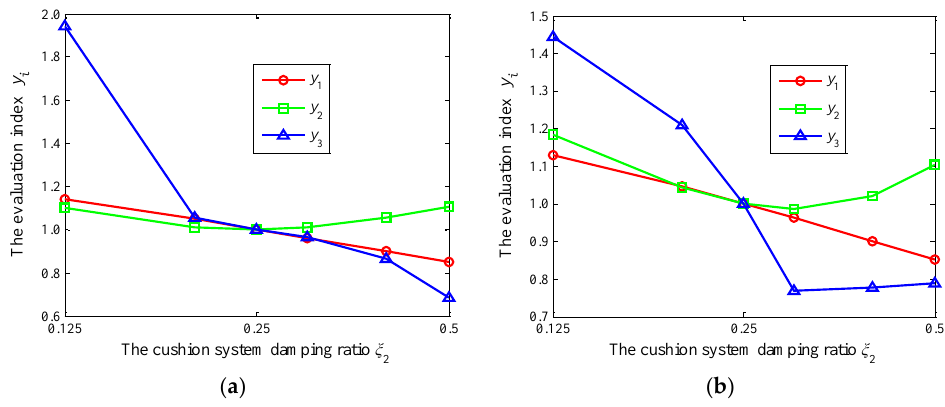
Figure 16. The evaluation index y i versus the cushion system damping ratio ξ 2 for the wheelchair: ( a ) going up the step; ( b ) going down the step.